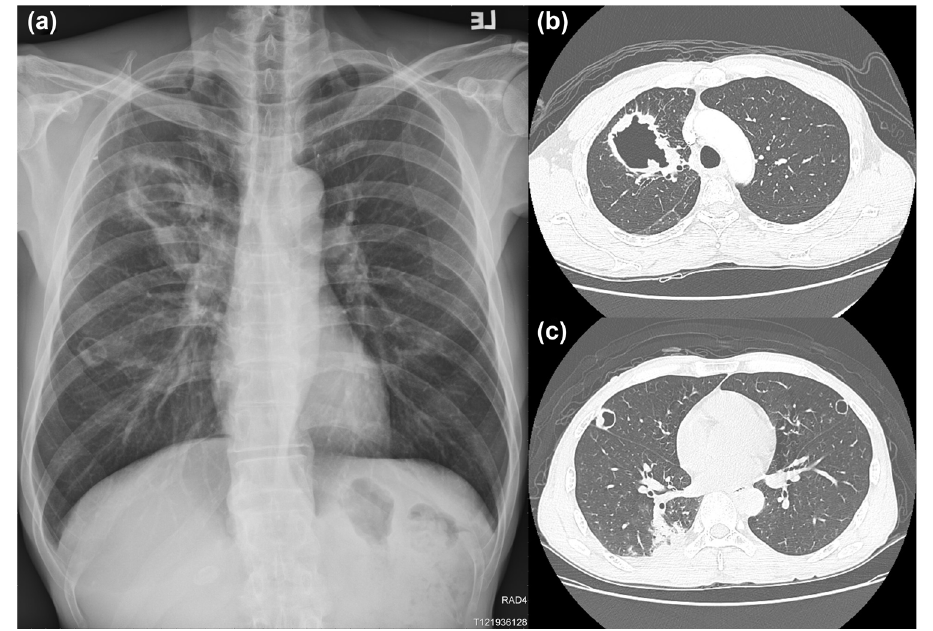
Figure 1: Chest radiography and computed tomography upon initial presentation: ( a ) RUL cavitary lesion and two cystic lesions within the bilateral upper lung fi eld and ( b and c ) a cavity with a ball - in - hole lesion in RUL and two small cystic lesions in the bilateral upper